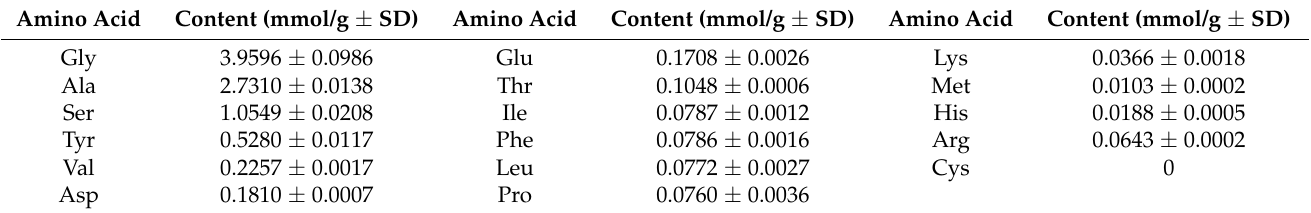
Table 2. Amino acid composition and content of SSF.